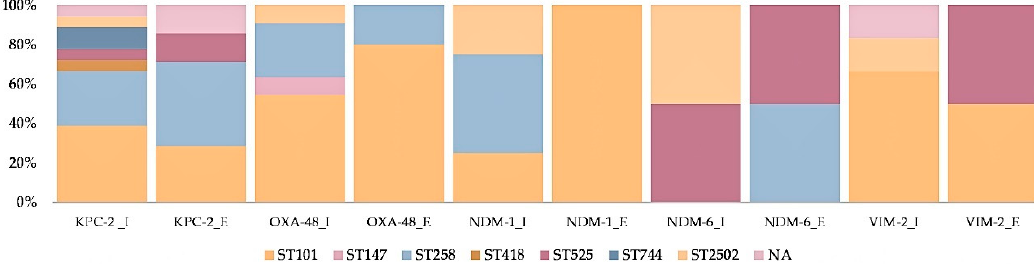
Figure 2. K. pneumoniae Sequence Type diversity and the association with carbapenemase genes in raw (influent-I) and treated (effluent-E) wastewaters.